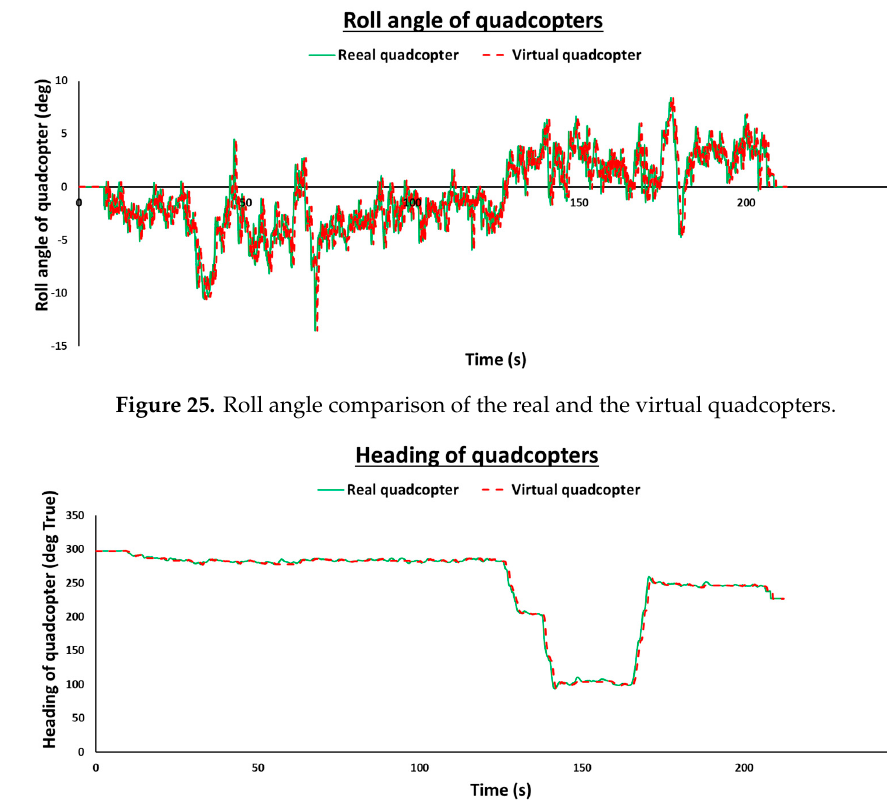
Figure 26. Heading comparison of the real and the virtual quadcopters.